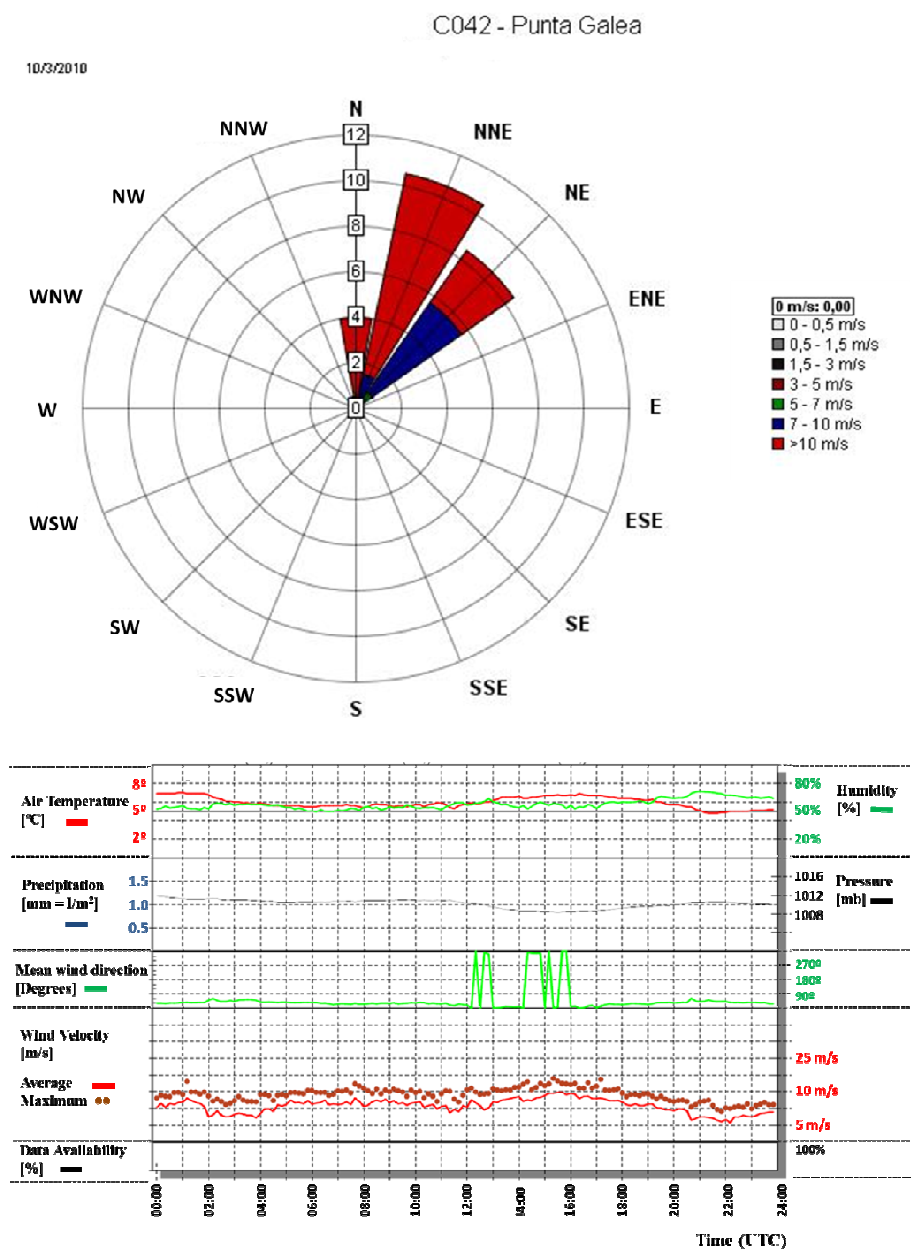
Fig. 5. North pattern: automatic weather station observations on 10 March 2010. (top) Wind rose. (bottom) Meteorological parameter measurements: air temperature, humidity, precipitation, pressure, mean wind direction, and wind velocity.